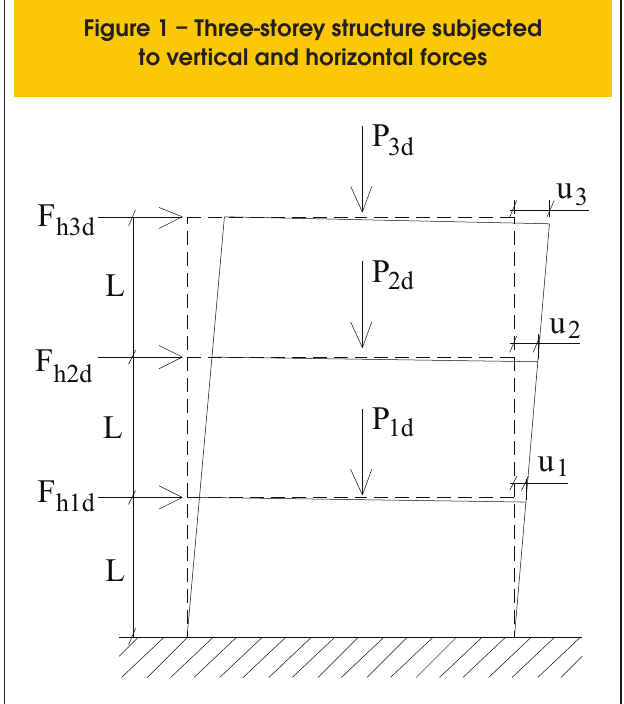
Figure 1 – Three-storey structure subjected to vertical and horizontal